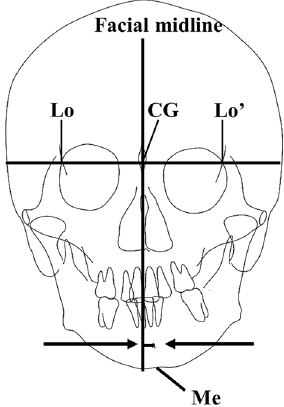
Fig. 2 Measurement of Me deviation (perpendicular distance from the facial midline to